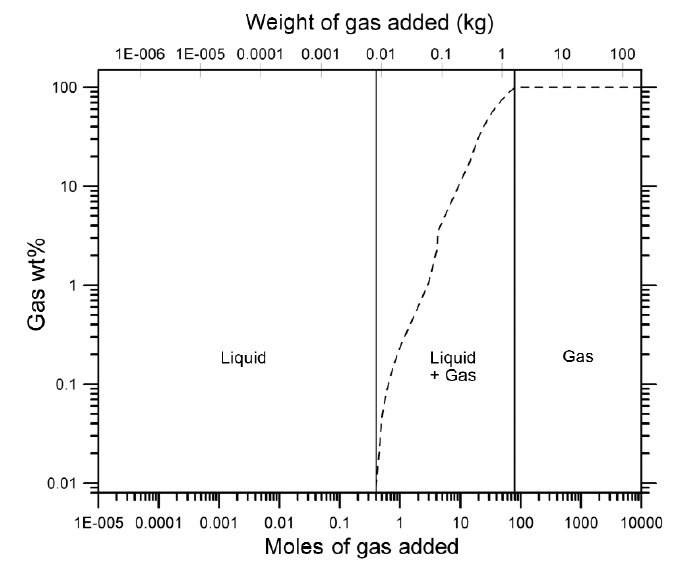
Fig. 10. Weight percentage of gas in the system during the progressive addition of hot (915°C) magmatic gas into 1000 g of pure water initially at 25°C. Pressure was kept at 0.1 MPa throughout the